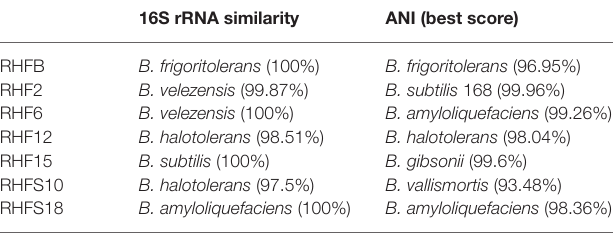
TABLE 4 | Classification of the seven selected strains.